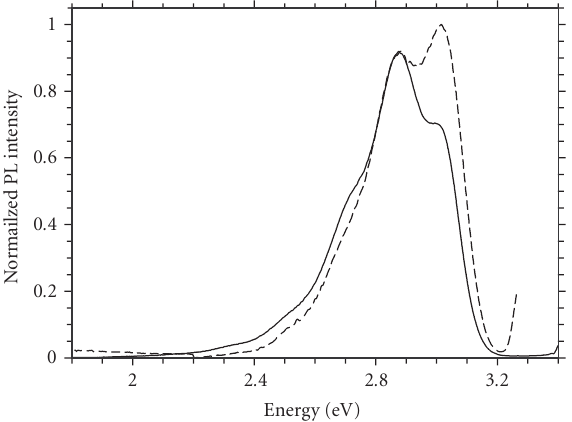
Figure 4: PL spectra of MCM-DPA sample (solid line) and DPA- water-CTACl ternary system (dashed line), excited with Hg lamp in the range 3.26–3.76 eV and with Xe lamp at 3.15 eV,